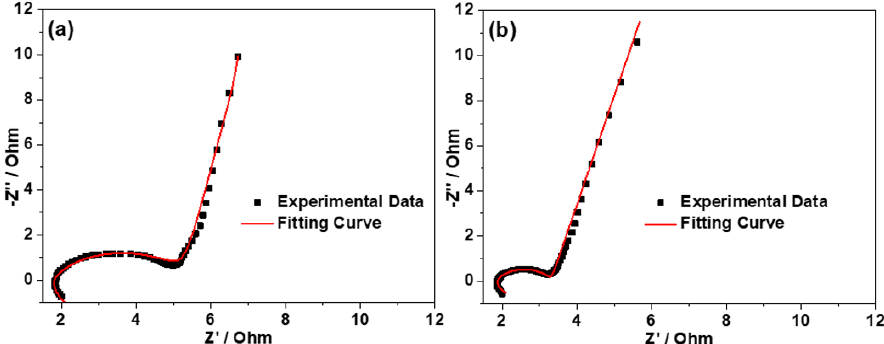
Figure 5. Nyquist plots of the MnO 2 ( a ) and the MnO 2 @VGCFs ( b ) in 0.5 M K 2 SO 4 aqueous elec-